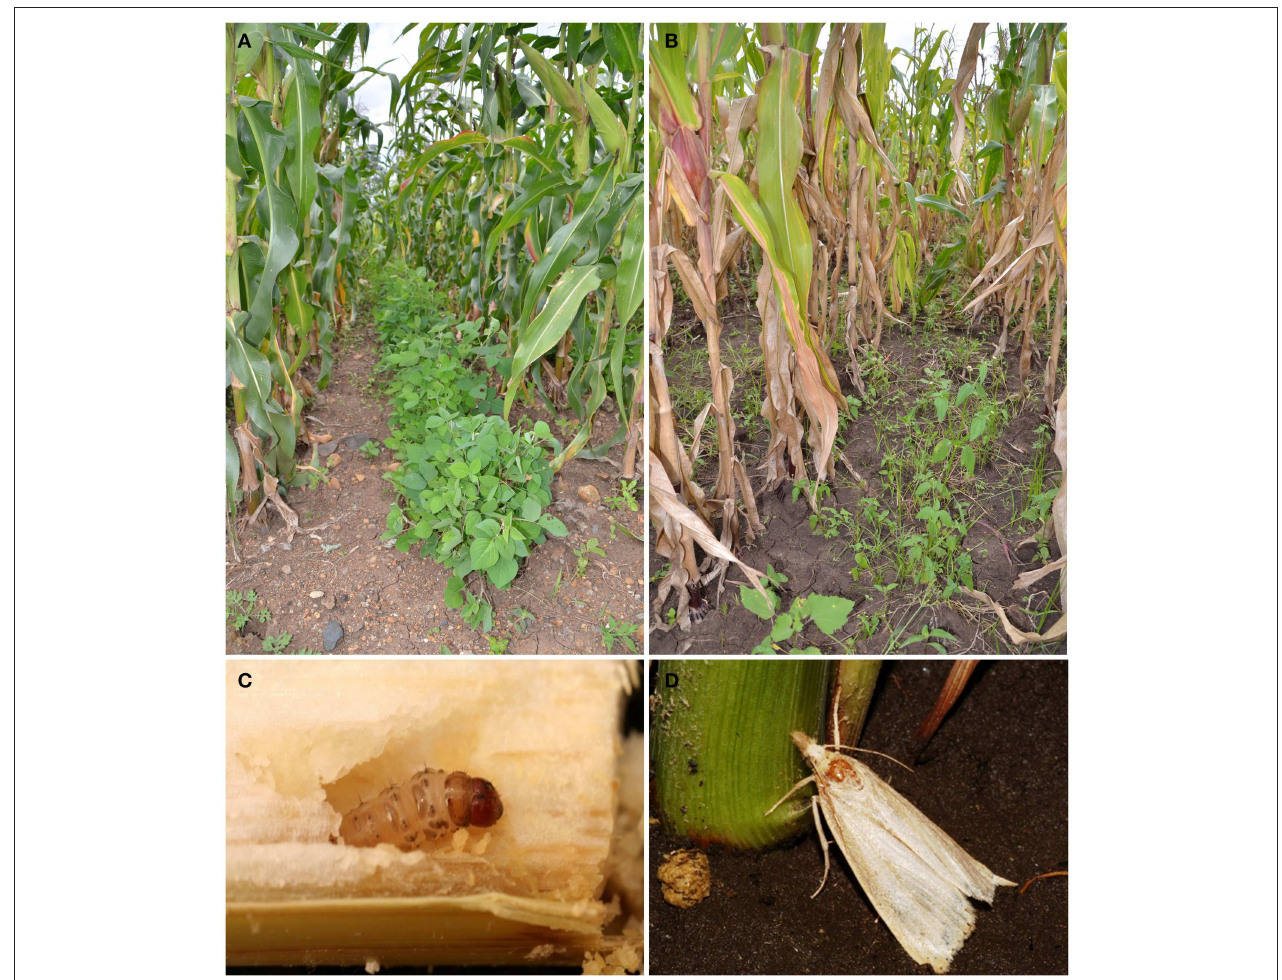
FIGURE 1 | The Push-Pull cropping system. (A) Push-Pull maize ( Zea mays ) field with green-leaf desmodium, Desmodium intortum, in the undergrowth as the push companion crop. The pull crop is not shown in this image. (B) Conventional maize field with weeds in the undergrowth. The push-pull cropping system is efficient in controlling stem-boring Lepidoptera, such as Chilo partellus whose larvae (C) start feeding on the leaves before boring into the stem with usually fatal effects to the plant. (D) Adult Chilo partellus